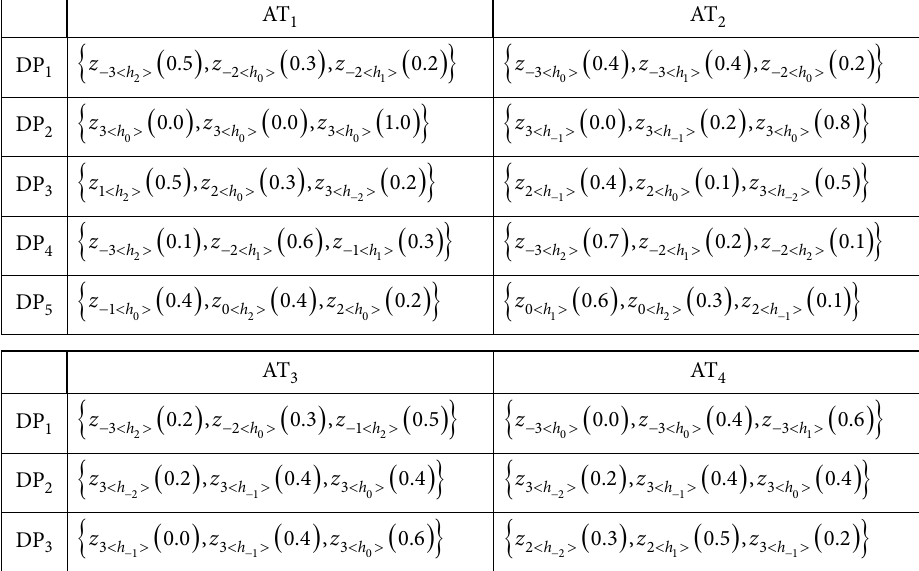
Table 6. The normalized PDHLTSs evaluation of each alternative is provided by e 3 AT 1 AT 2 DP 1